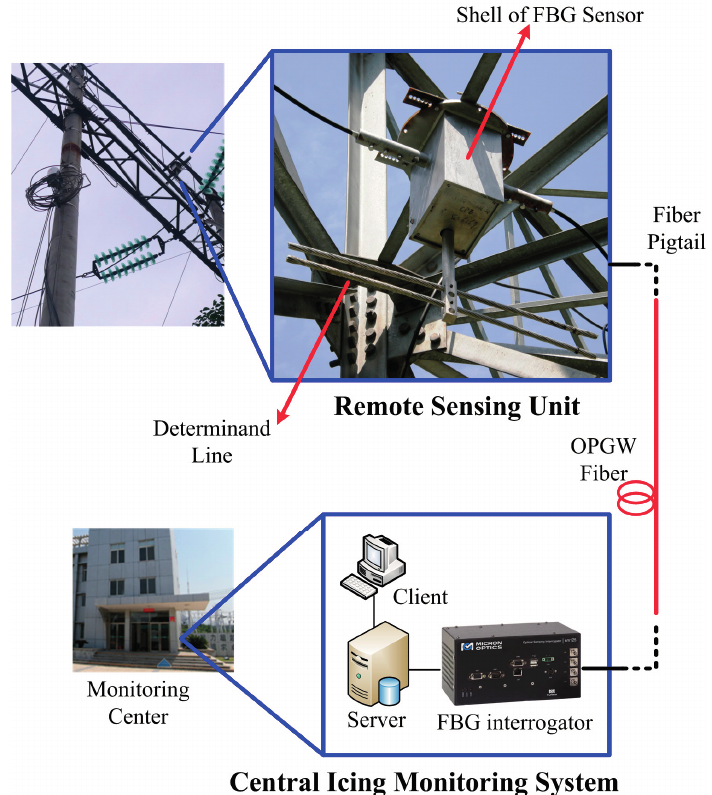
Figure 4. Implemented icing monitoring system in the